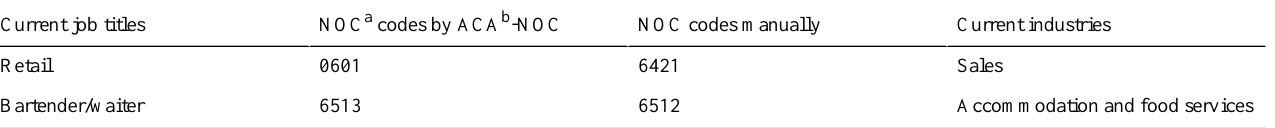
Table 8. Unmatched data example for Generation 2.